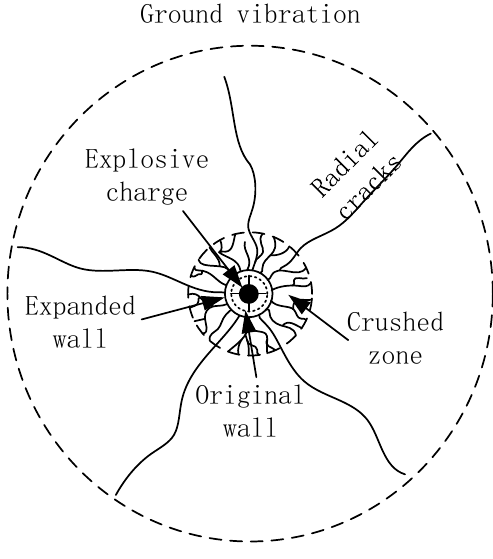
Figure 3. Crack formation around a blast hole.